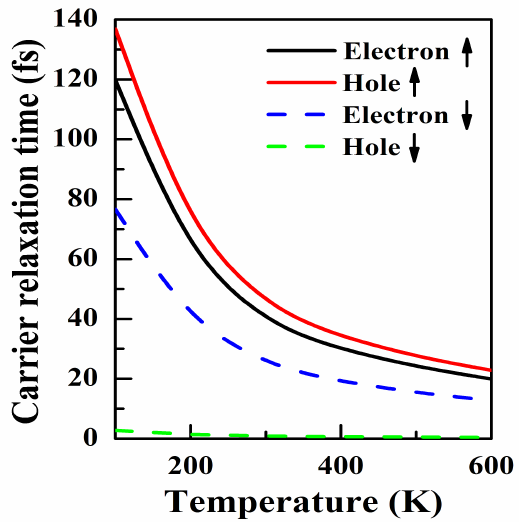
Figure 3. The obtained relaxation time for electron and hole for both spin channels when the temperature enhance from 100 K. ( ) represents spin-up (spin-down) direction. ↑ ↓